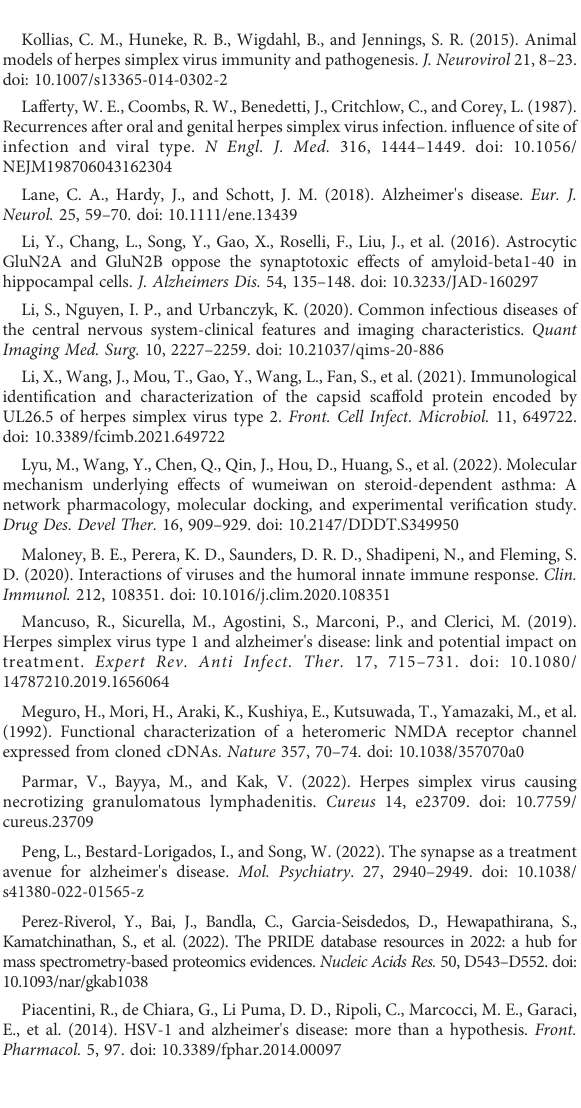
SUPPLEMENTARY FIGURE 3 Proteomics work fl ow for label-free quantitation of proteins from brains after vaginal infection with